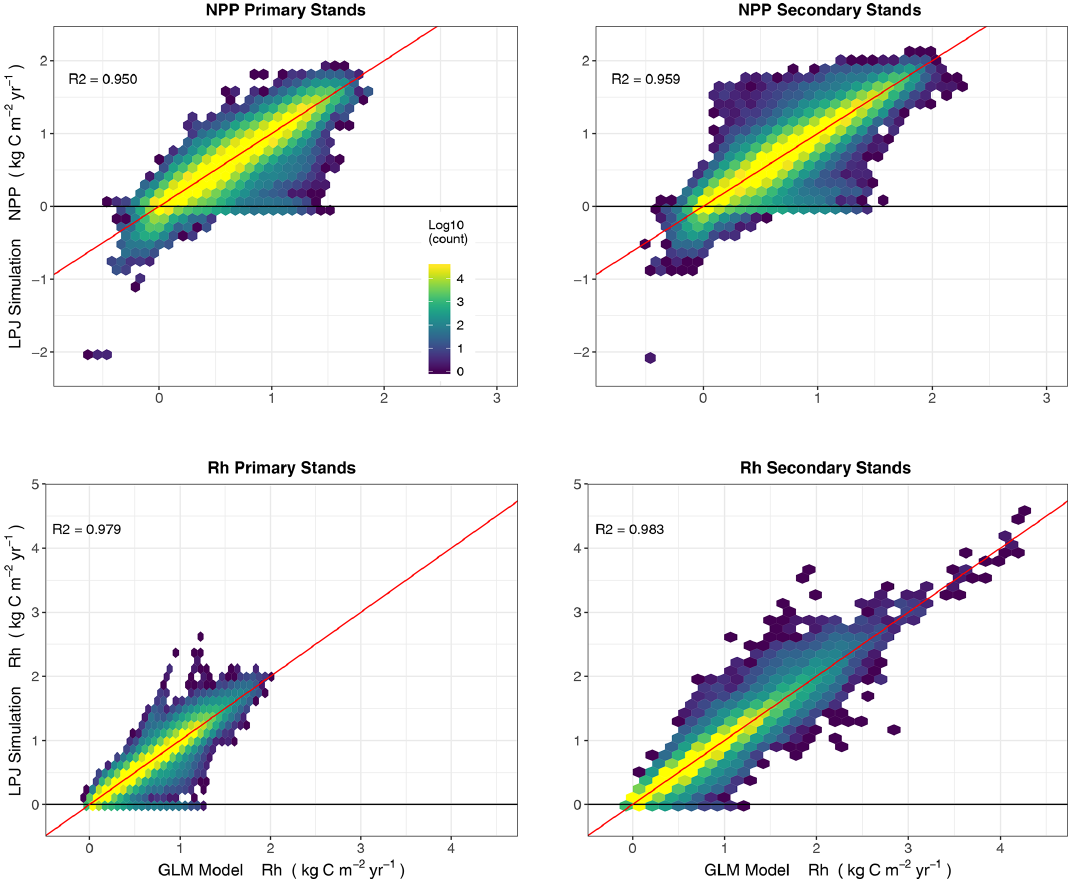
Figure 10. Annual fluxes (NPP, Rh) (2000–2017) from LPJ-wsl v2.0 simulations versus predictions of LPJ-wsl v2.0 fluxes based on a generalized linear model (GLM; flux is the sum of precipitation, temperature and age class); coefficients were allowed to vary by grid cell, in essence, reducing the effect of variation in plant composition, soil texture, and hydrology. Coloring is by density of grid cells on a log scale; diagonal red line is the 1 : 1 correspondence line. The simplified statistical model can simplify the dynamics in the global vegetation model, with coefficients from the GLM helping to determine the relative importance of a small set of